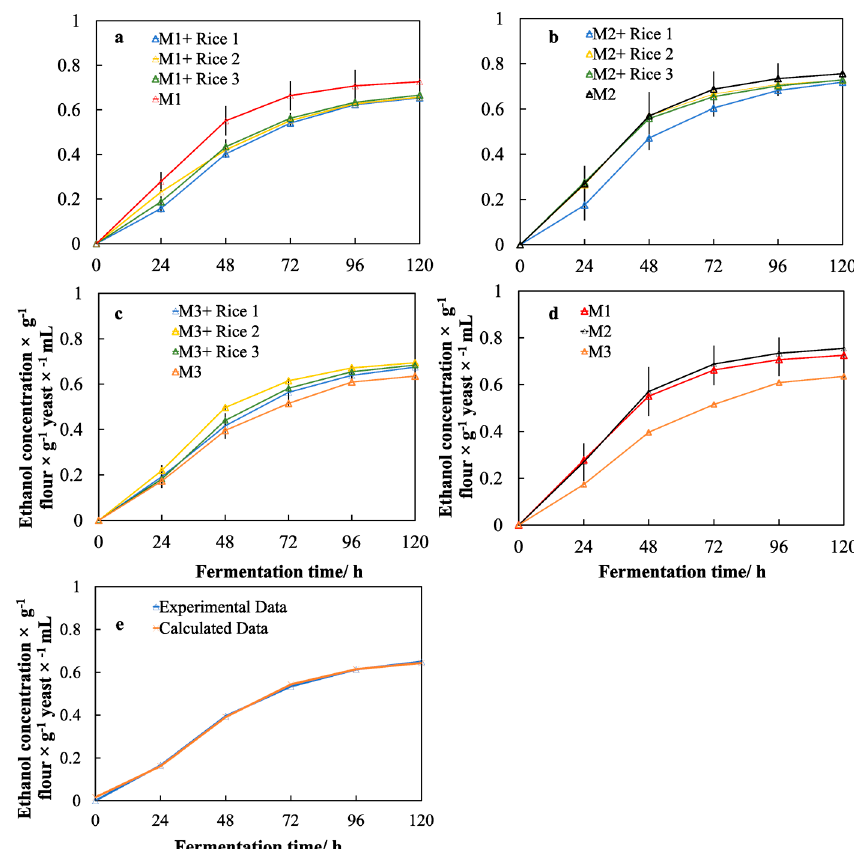
Figure 3. Production of ethanol during fermentation of different barley malts with different rice adjuncts: Malt 1 ( a ); Malt 2 ( b ); Malt 3 ( c ); pure malt ( d ); and model fitting ( e ). Data was based on both biological and technical duplicate measurements.